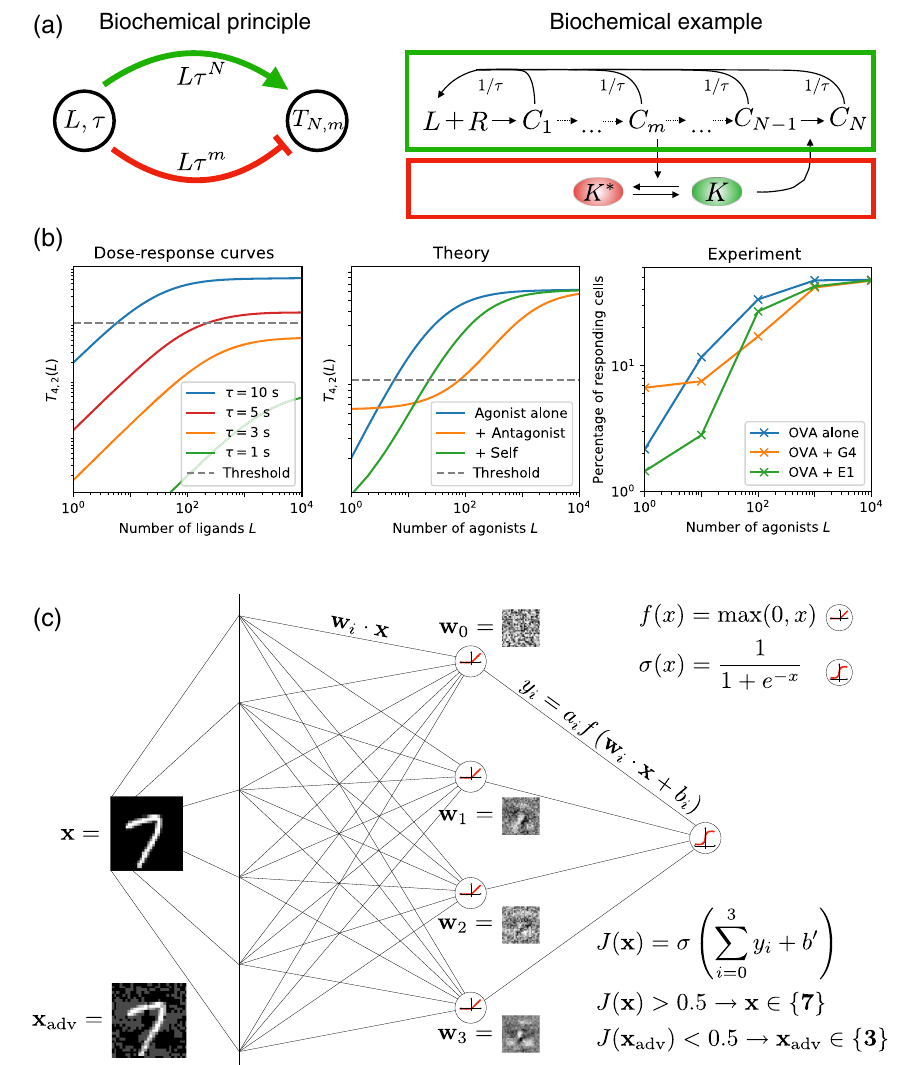
FIG. 2. Adaptive proofreading and neural network. (a) Left: Adaptive proofreading networks have an activating and repressing branch with different weights on τ . Right: Detailed adaptive proofreading network adapted from Ref. [34]. Ligand L binds to receptor R to form unphosphorylated complex C 0 . The receptor chain is iteratively phosphorylated until reaching state C N along the activating branch (green). At every stage C i , the ligand can unbind from the receptor with ligand-specific rate τ − 1 . At C m , the repressing branch (red) splits by inhibiting the kinase K , which mediates the feed-forward mechanism. (b) Dose-response curves for pure ligand types and mixtures in both adaptive proofreading models and experiments on T cells (redrawn from Ref. [32]). Details on the models and parameters used